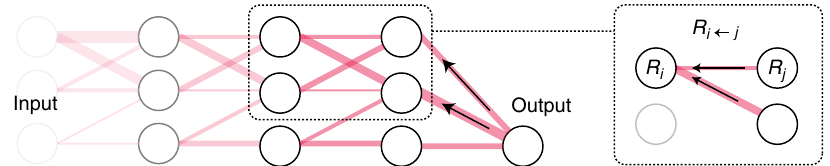
Fig. 7 Layer-wise relevance propagation. LRP decomposes the problem of explaining a complex multilayer neural network model into simpler sub- functions that are easier to analyze and explain. The relevance score at input neuron R i is obtained by pooling all incoming relevance values R j from the output neurons in the next